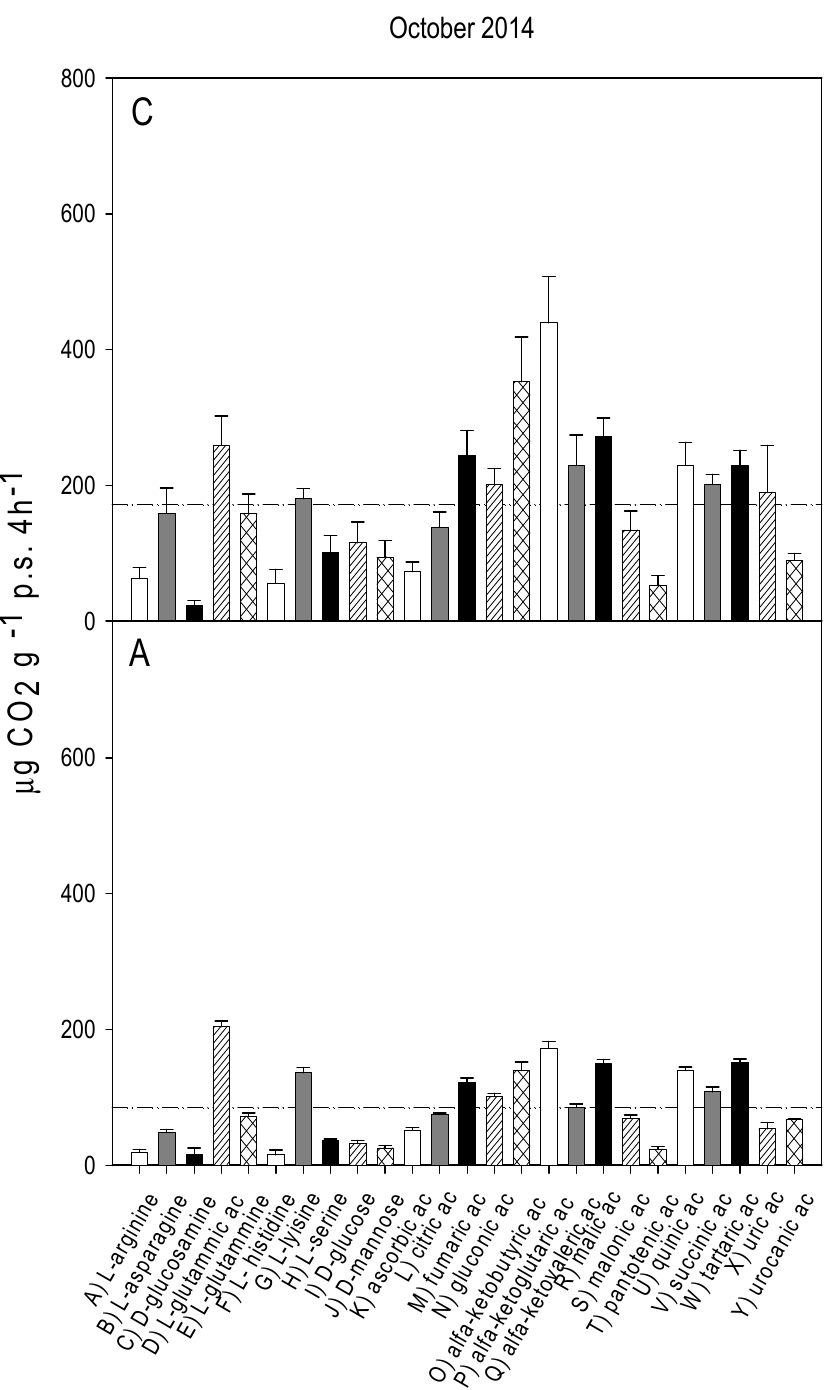
Figure 3. Catabolic response profile of chestnut ( C ) and agricultural ( A ) soils in October 2014. The dotted line represents the average substrate-induced respiration (ASIR), corresponding to 171 ± 15.3 in chestnut and to 84.9 ± 2.5 in agricultural soil (the values were not significantly different).